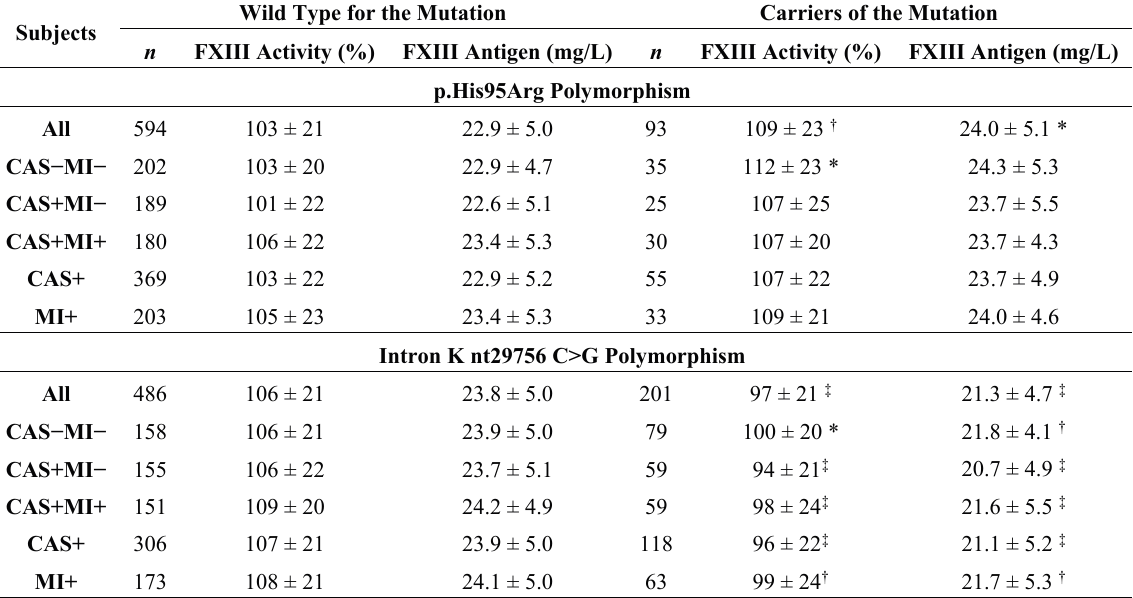
Table 5. The effect of FXIII-B subunit polymorphisms on FXIII activity and antigen concentration.